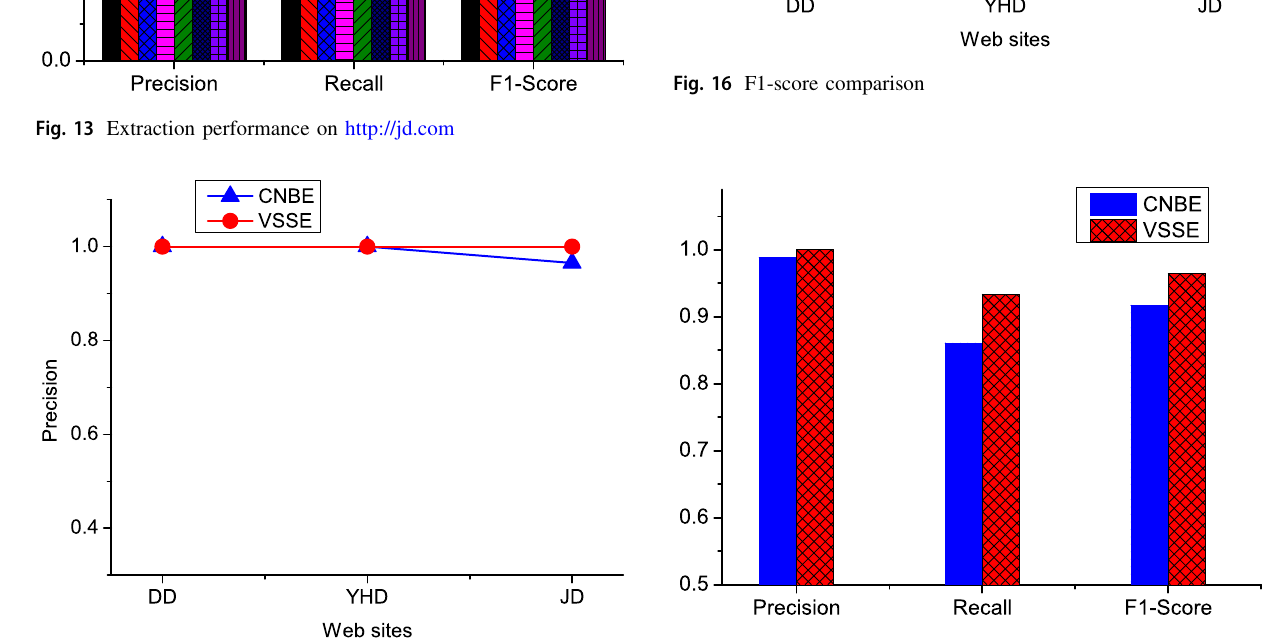
Fig. 17 Overall performance